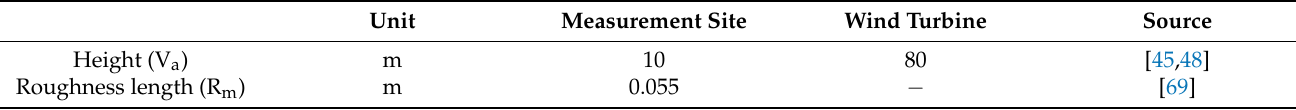
Table A5. Values used for wind correction Table A6. Table used for determination of roughness class for wind speed correction calculation.